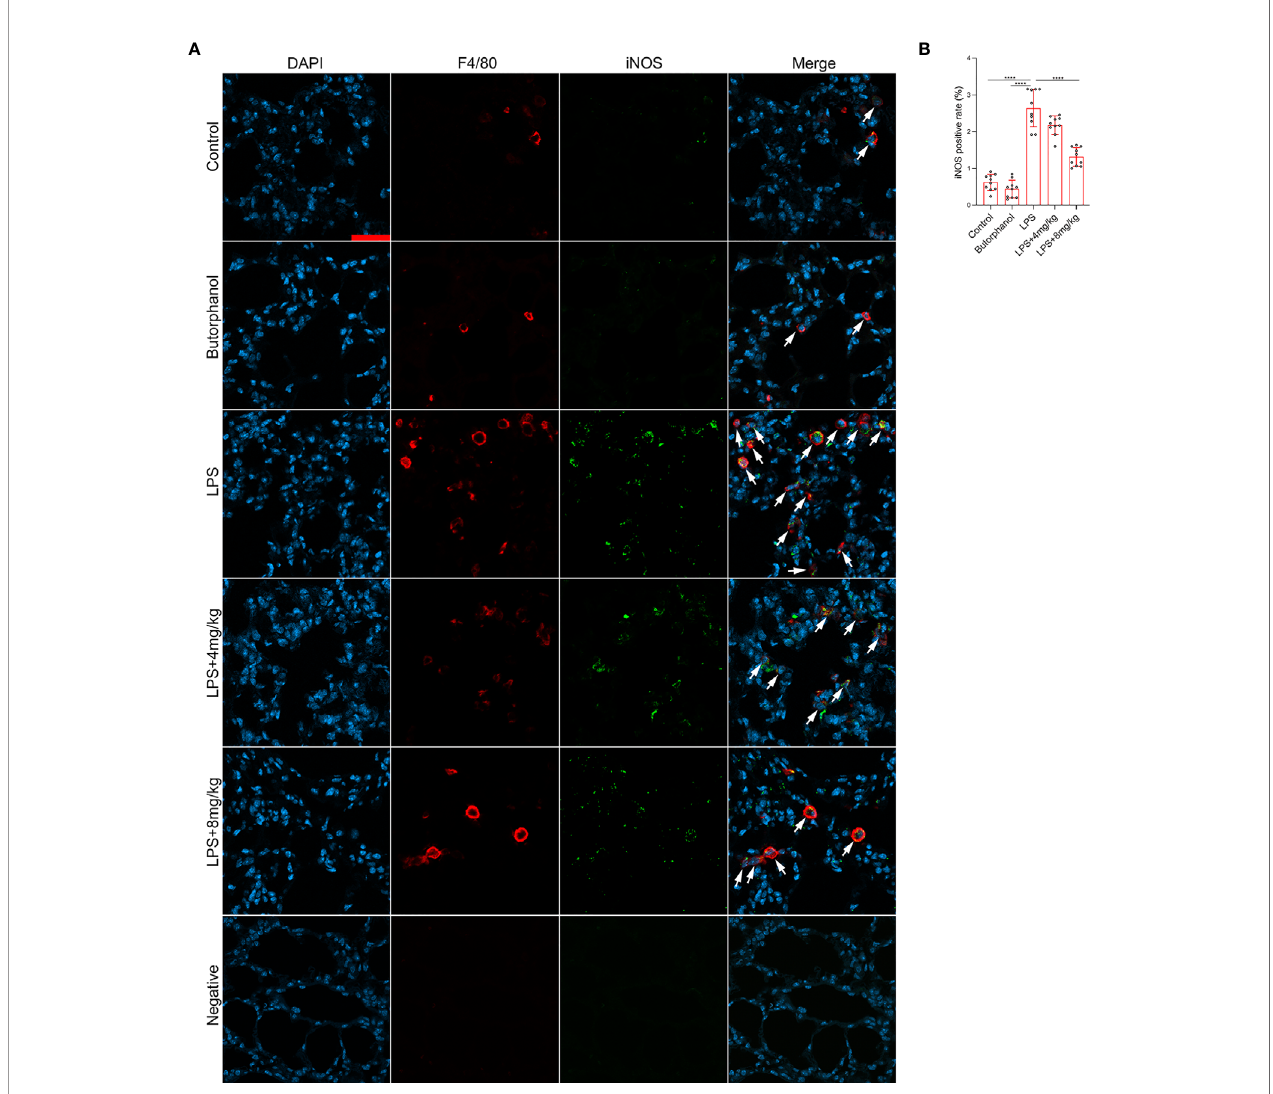
FIGURE 2 | Butorphanol administration inhibited M1 macrophage polarization in LPS-induced lung injury. Mice were injected with LPS ( 10 mg·kg -1 i.p.) or butorphanol (8 mg·kg -1 i.p.) or butorphanol (4 mg·kg -1 i.p. or 8 mg·kg -1 i.p.) plus LPS (10 mg·kg -1 i.p.) and analyzed after 24 h. (A) Sections were stained with antibodies against F4/80 (red) and iNOS (green). Scale bar: 25 m m. (B) The image analysis results are presented as the percentage of iNOS-positive F4/80 cells. The results are the means ± SEM of ten independent experiments. Statistical analysis was performed by one-way ANOVA followed by Tukey ’ s post hoc test when comparing multiple independent groups. ****P <